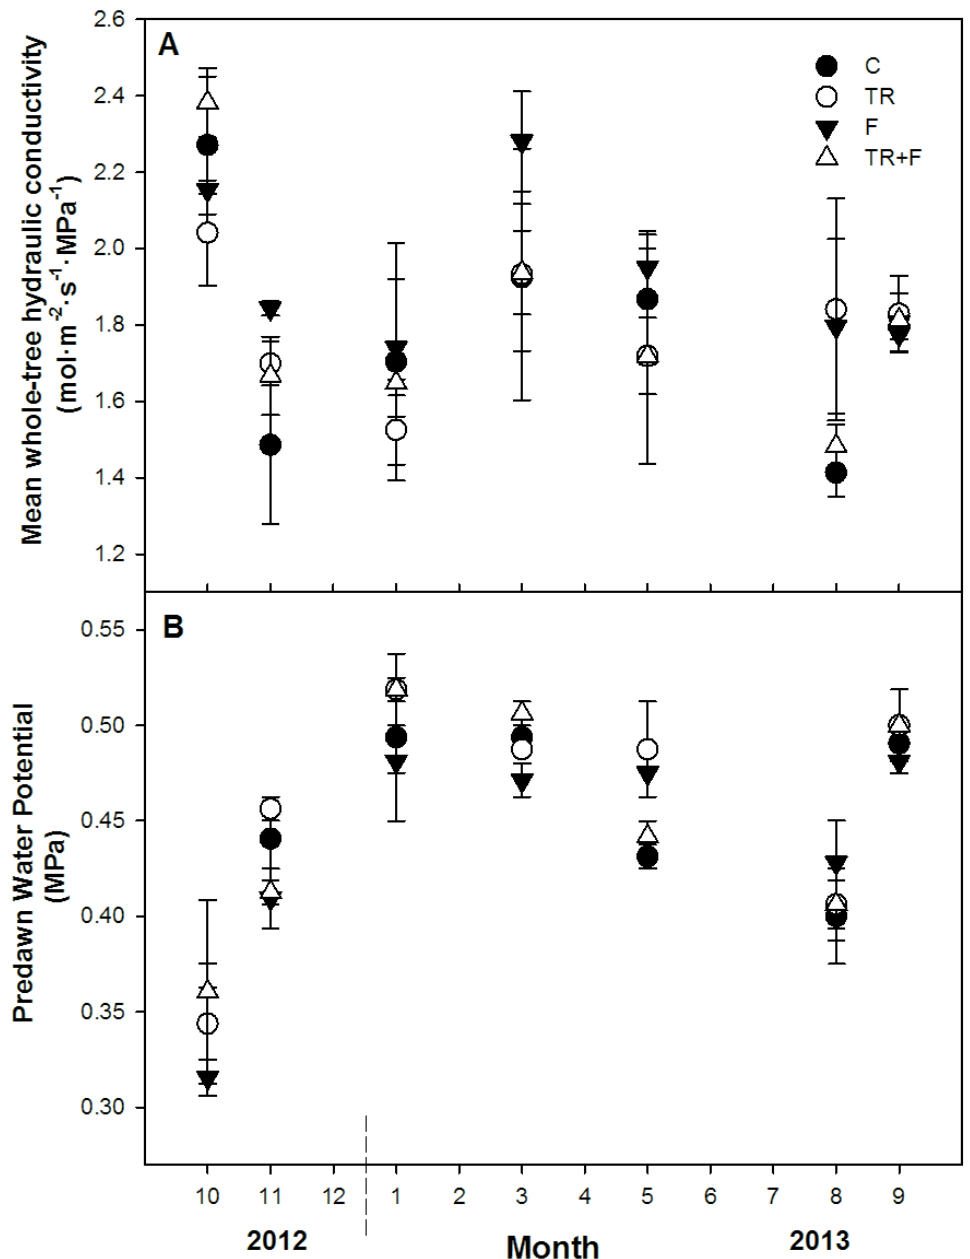
Figure 2. Mean whole-tree hydraulic conductance ( A ) and predawn water potential ( B ) for each measurement date from October 2012 (Month = 10) to November 2013 (Month = 9) for control (C), throughfall reduction (TR), fertilizer application (F), and throughfall reduction and fertilizer application (TR+F) treatments. Error bars represent ± 1 standard error.